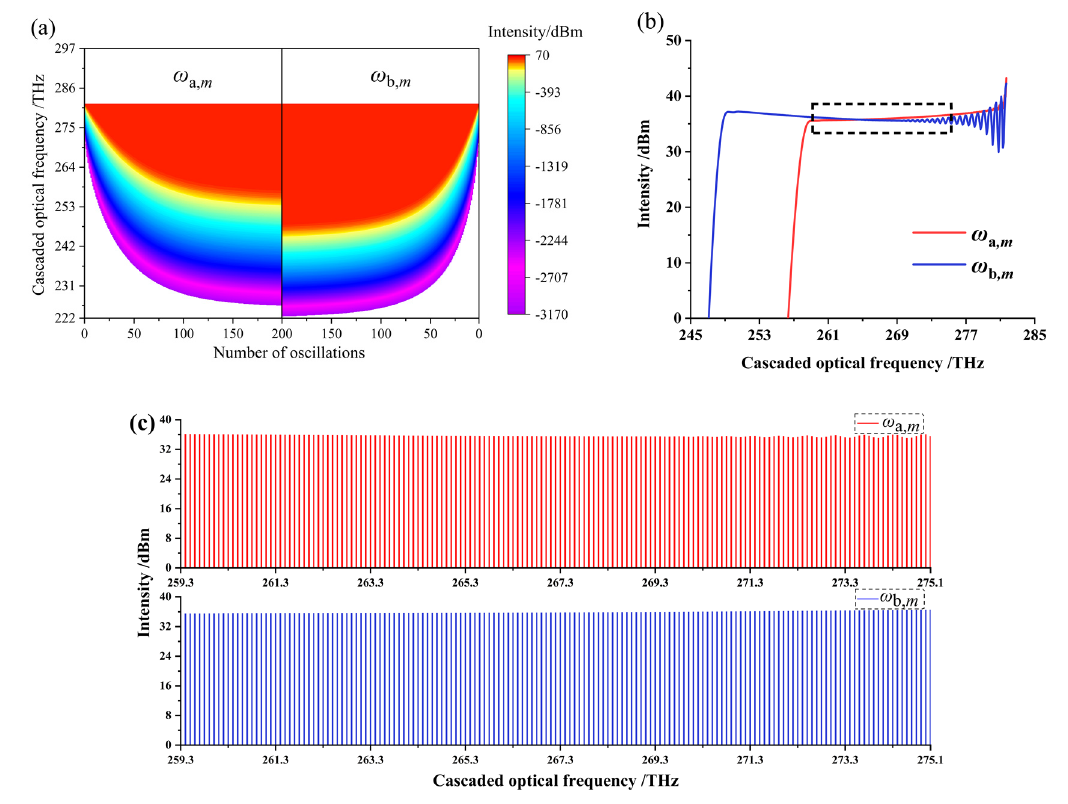
Figure 2. Evolution of DOFC generated by DCDFG within the OPO. m = 200, L = 6 cm, I 0 = 100 MW/cm 2 , I 1 = 1 MW/cm 2 , I 2 = 1 MW/cm 2 . ( a ) Evolution of ω a, m and ω b, m with oscillation number N . ( b ) Spectral distribution of ω a, m and ω b, m with N = 200; the range covered by the dashed box was DOFC within 1 dB flatness. ( c ) Enlargement of the range covered by the dashed box in ( b ). From Equation (8), we find that cascading order m can influence phase mismatches Δ k a/b, m . Figure 3a shows the spectral distribution of DOFC with different cascading order m , and the dashed boxes in Figure 3a corresponding to DOFC were enlarged, shown in Figure 3b. The spectral range of DOFC within 1 dB flatness was 262.9–272 THz for m = 50. With the cascading order m increasing from 50 to 100, 150, 200, and 250, DOFC spectral range within 1 dB flatness firstly expanded and then reduced. The largest spectral range was 259.3–275.2 THz for m = 200. With the cascading order m increasing from 50 to 100, 150, 200, and 250, the comb line number of the DOFC within 1 dB flatness increased from 92 to 102, 121, and 160, and then decreased to 100. The DOFC spectrum range of 1086.96– 1156.96 nm within 1 dB flatness can be achieved with different cascading order m .